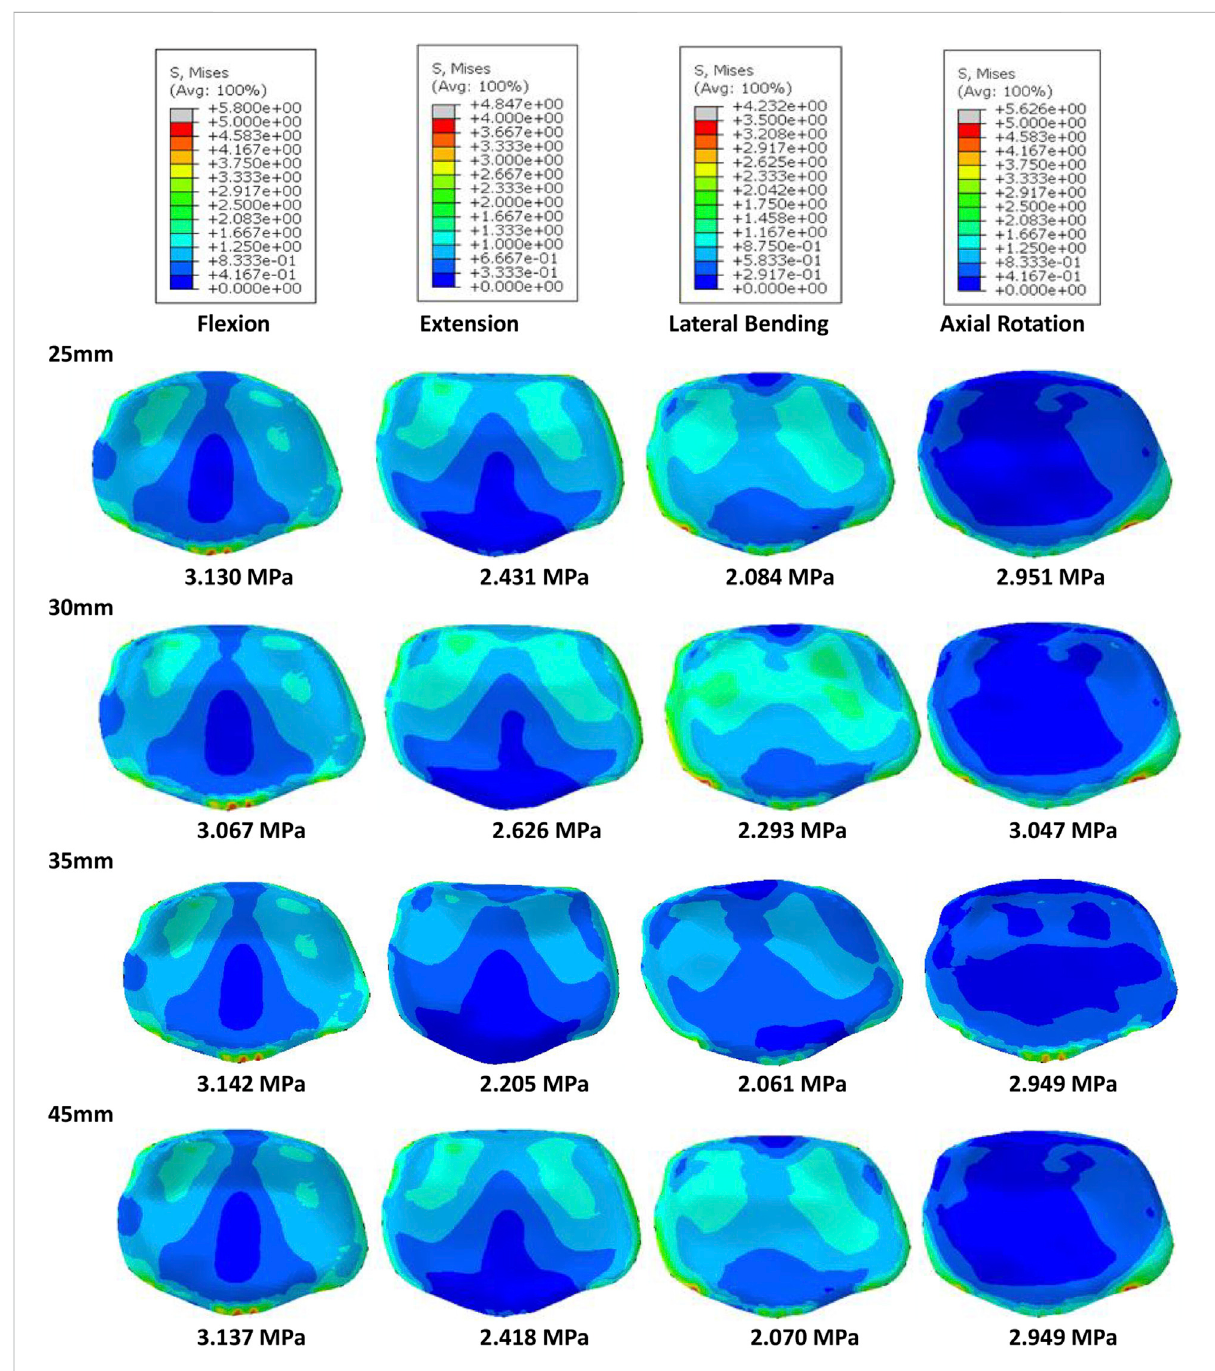
FIGURE 7 Von-Mises stress on the L5 endplate of the models for different rod lengths when placed under fl exion, extension, lateral bending, and axial rotation, with the mean stress noted beneath each image.